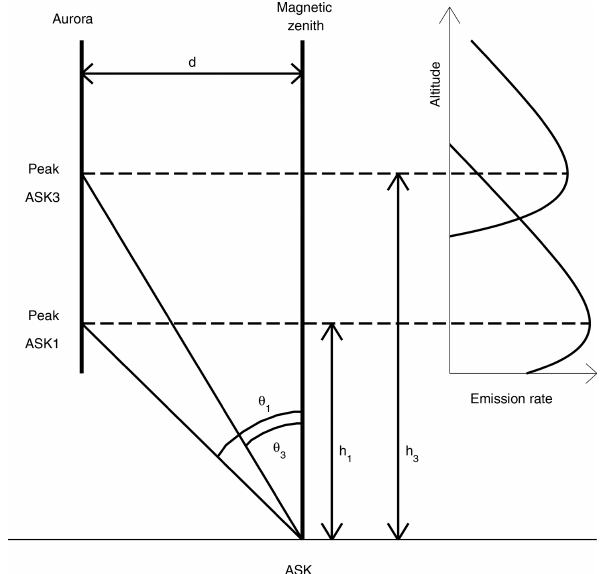
Figure 4. Representation of an ASK frame showing definition of image distance and